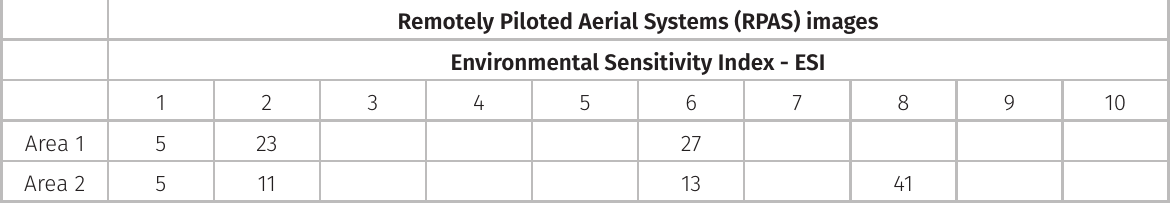
Table VII. Number of segments observed in each ESI class, using Remotely Piloted Aerial Systems (RPAS) images for ESI mapping for oil